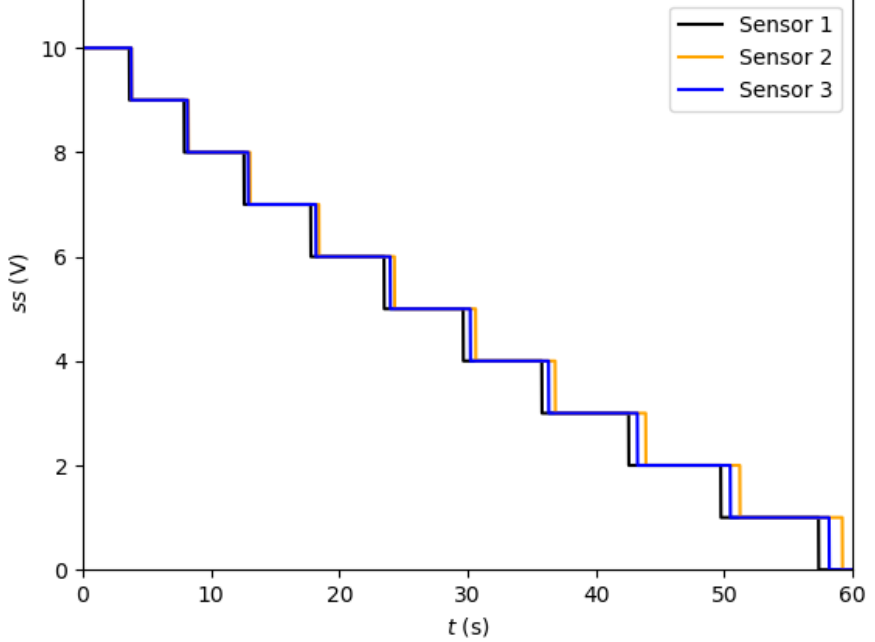
Figure 36. RBS signal, feedback with complete regulation law, case 2, ds = 3